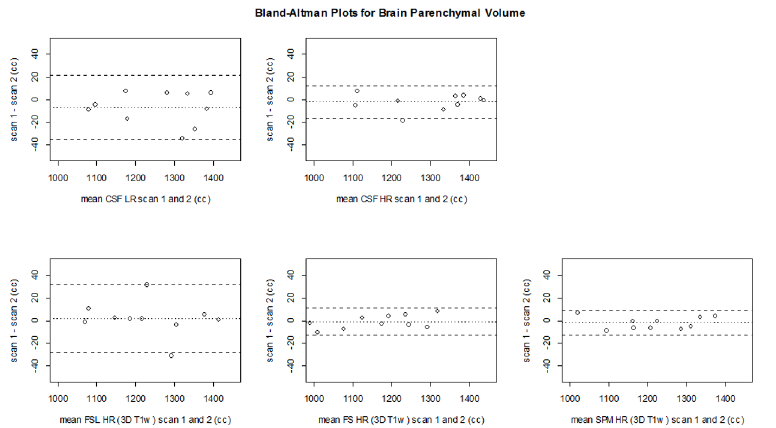
absolute differences for BPV between scans were comparable for the CSF HR sequence (5±5 cc) and FSL HR (9±11 cc), FSL LR (7±4 cc), FreeSurfer HR (5±2 cc), FreeSurfer LR (9±8 cc), SPM HR (5±3 cc), and SPM LR (5±4 cc) but the CSF LR (12±9 cc) showed somewhat larger mean absolute differences than FreeSurfer HR and SPM HR and LR. The Bland-Altman plots comparing the BPV obtained at the first scan versus that of the second scan for the CSF MRI sequence and the HR 3D T -based methods are shown in Fig 5. The Bland-Altman plots from 1 the downsampled 3D T sequence are shown in S2 Fig. The mean in the Bland-Altman plots 1 should be close to 0, indicating that there is a small absolute difference between scan 1 and scan 2 within methods. The mean was close to 0 for all methods. The limits of agreement in the Bland-Altman plots should be narrow, indicating a good precision. The limits of agree- ment were most narrow for SPM HR (-13–9 cc) and FreeSurfer HR (-13–11 cc), and SPM LR (-11–15).